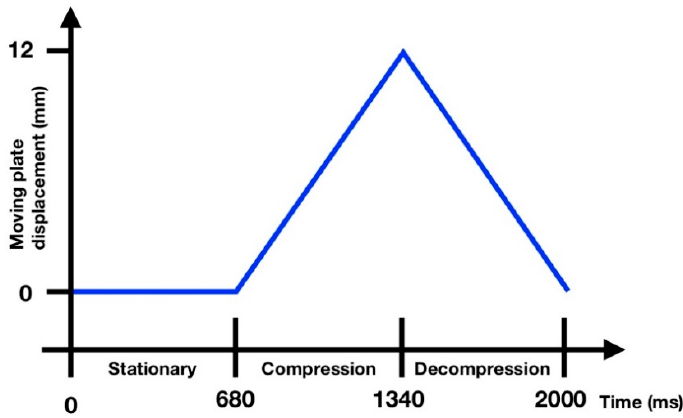
Figure 2. Moving plate displacement during a compression cycle. The cycle is broken up into three phases, stationary, compression, and decompression.